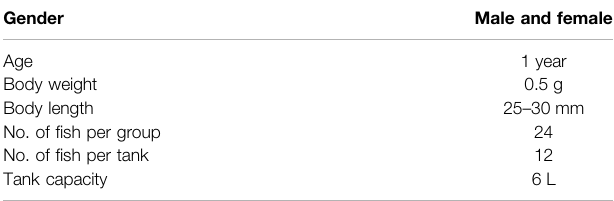
TABLE 1 | Inclusion criteria for model zebra fi sh in the study.